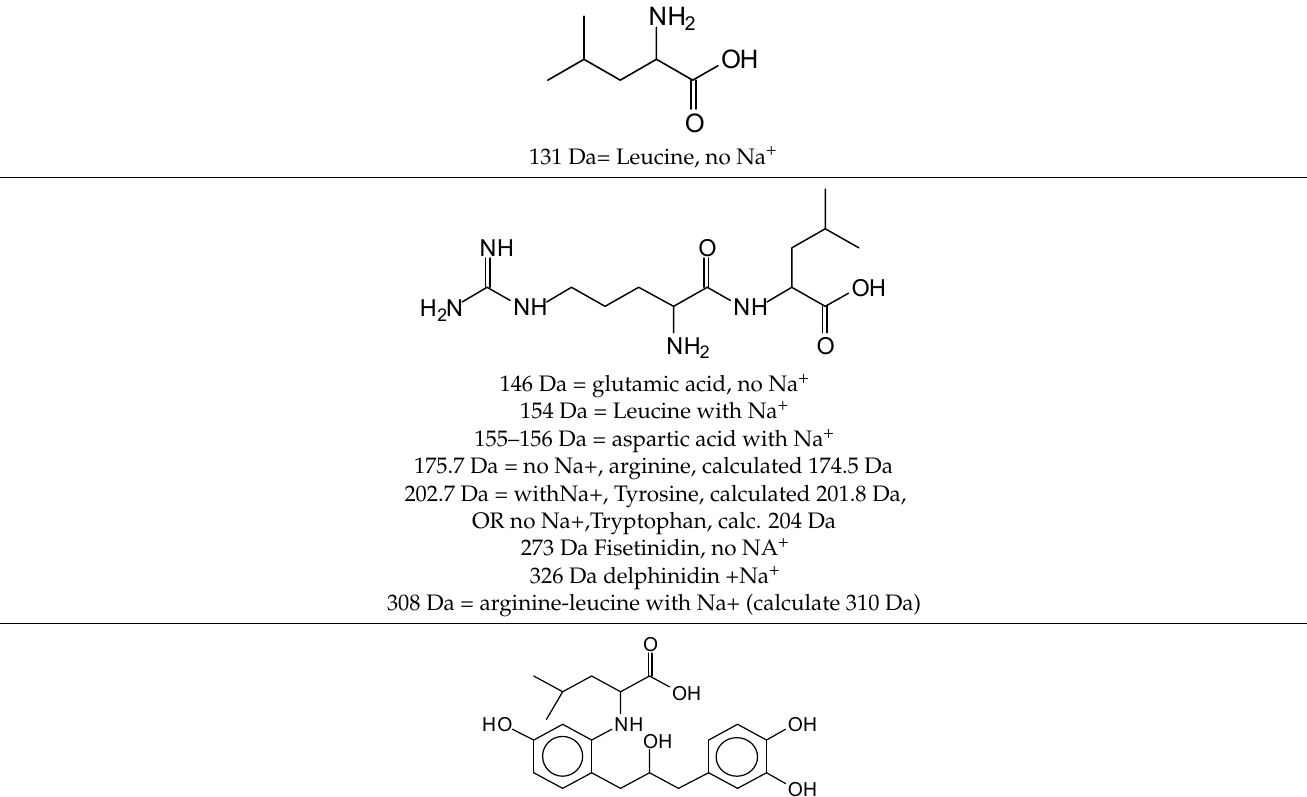
Figure 1. MALDI-ToF spectra of tannin-ISP adhesive.( a ) 100–300 Da range. ( b ) 300–500 Da range. ( c ) 700–1000 Da range. ( d ) 1000–1500 Da range. Table 1. Assignment of structures to relevant MALDI-ToF peaks from Figure 1 (a to d). Table 1. Assignment of structures to relevant MALDI-ToF peaks from Figure 1a to Figure 1d.